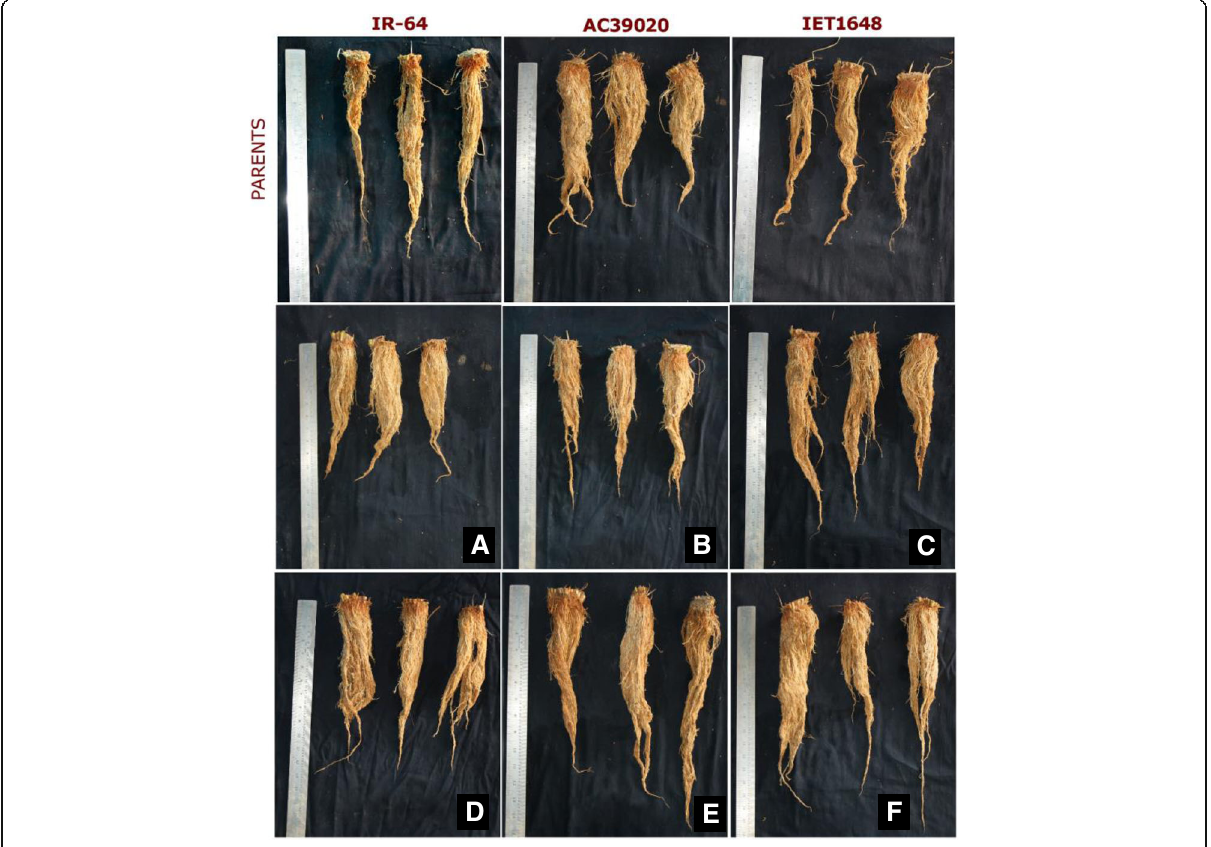
Fig. 2 Improvement in root traits of TILs as compared to parents. a -TIL-32-1-40-84-54, b -32-1-40-24-57, c -32-1-40-78-84, d -81-23-27-378-93,